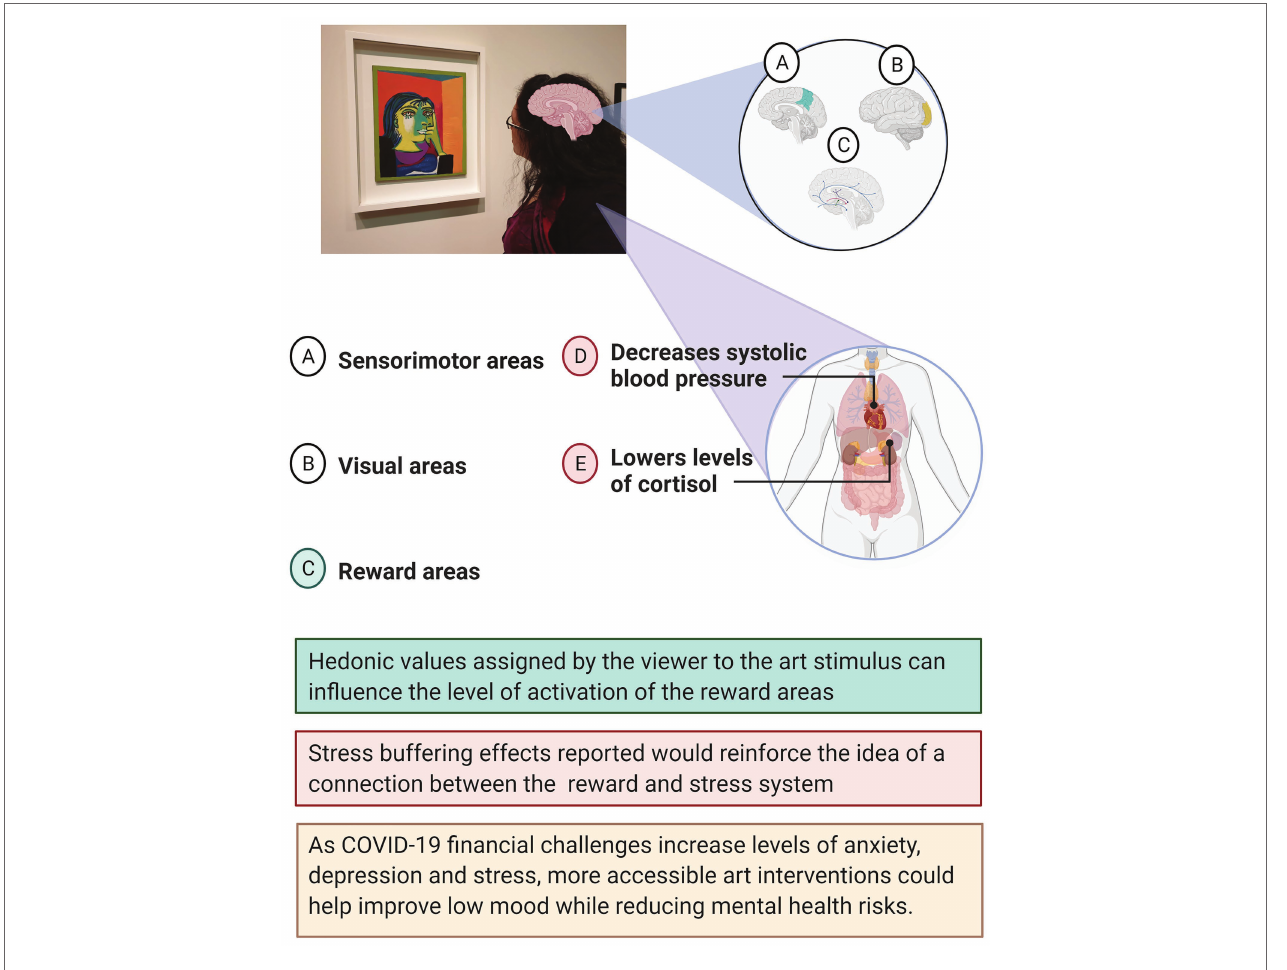
FIGURE 1 | Schematic diagram for neural activation and stress buffering physical effects of visual art